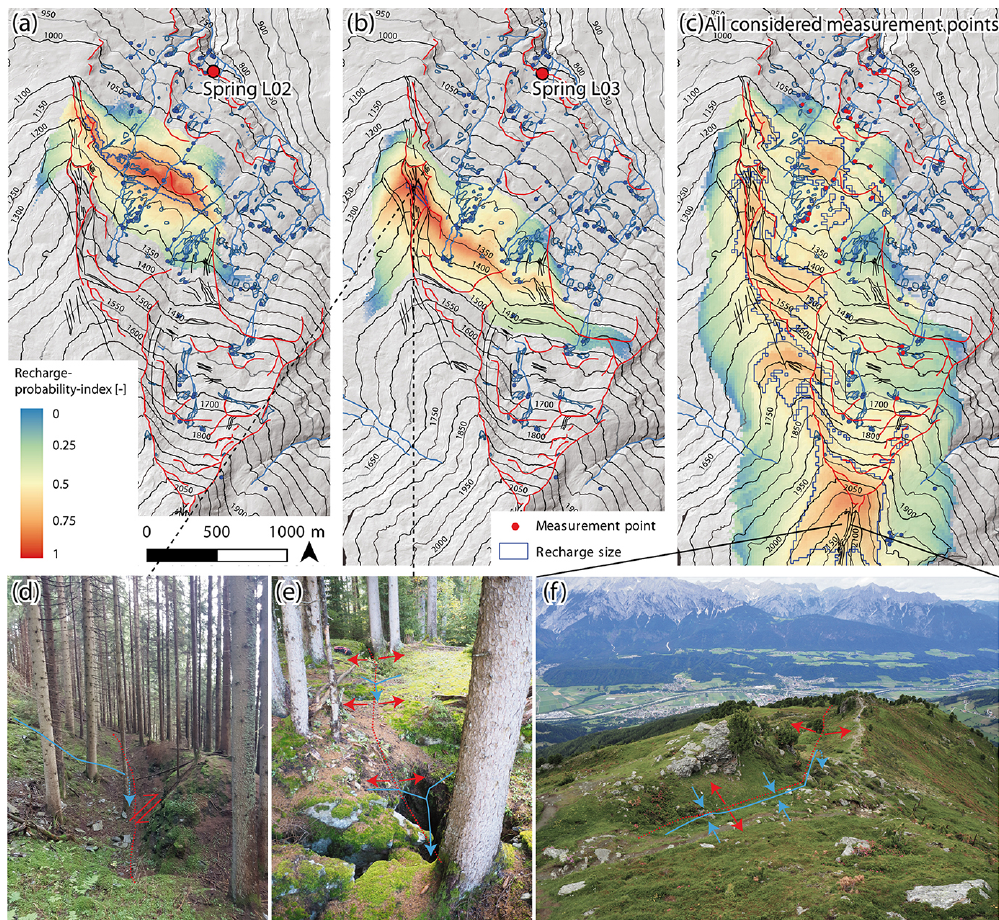
Figure 9. Maps of probable recharge. Panels (a) and (b) show the recharge probability index for selected springs draining the active landslide, and (c) shows an aggregated map considering recharge probabilities for all spring, drainage, and well samples. Panel (d) shows a picture of an upslope-facing scarp assumed to represent a recharge zone (assumed flow paths indicated by blue arrow lines), as well as (e) open tensional fractures and (f) a dry valley between a double-crested ridge (DTM source: Federal State of Tyrol). Table 3. Summary of identified flow systems and their properties. Proximal Distal Discharge elevation [ m ]